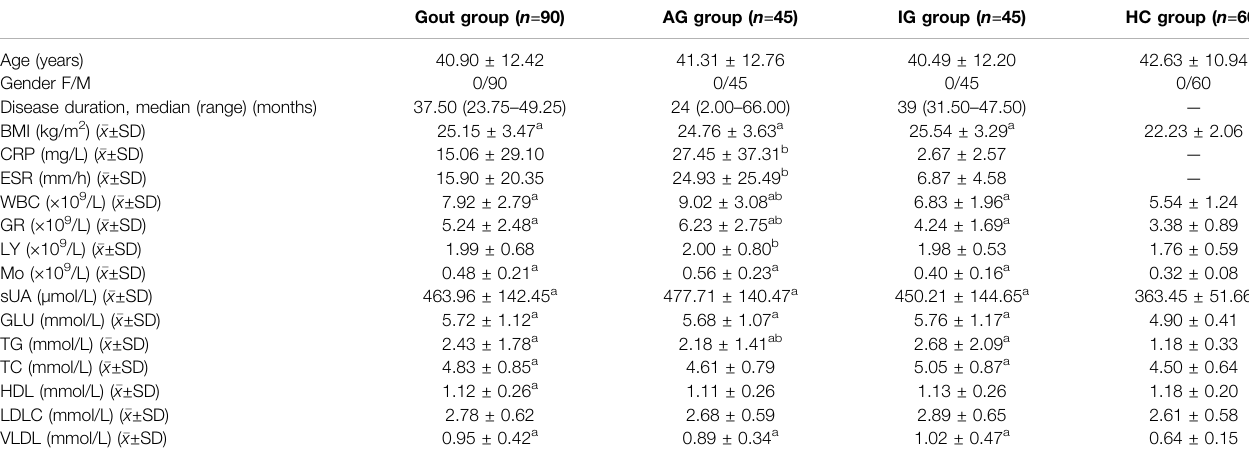
Gout: primary gout, including acute gout fl are and intercritical gout; AG: patients with acute gout fl are; IG: patients with intercritical gout; HC: healthy controls ; (cid:1) x ± SD: mean ± standard deviation;BMI ： BodyMassIndex;CRP:reactiveprotein;ESR:erythrocytesedimentationrate;WBC:whitebloodcellcounts;GR:neutrophilegranulocytecounts;LY:lymphocytecounts; Mo: monocyte counts; sUA ： serum uric acid; GLU:serum glucose; TG: triglycerides;TC: Total Cholesterol;HDL: high-density lipoprotein;LDL: low-densitylipoprotein; VLDL: very low- density lipoprotein. One-way ANOVA, T test or Mann Whitney test. p-value < 0.05 was considered to denote statistical signi fi cance a in comparison with HC group b in comparison with IG